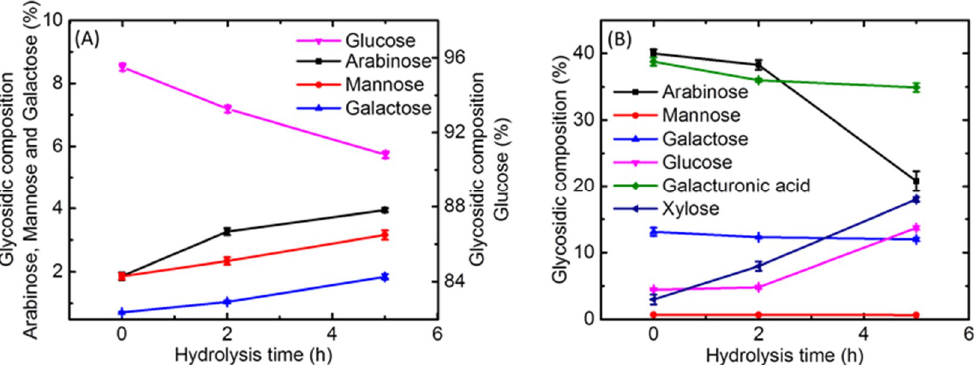
Figure 3. Glycosidic composition and corresponding molar percentages during the hydrolysis developing from 0 h to 5 h. ( A ), the water-soluble polysaccharide; ( B ), the insoluble